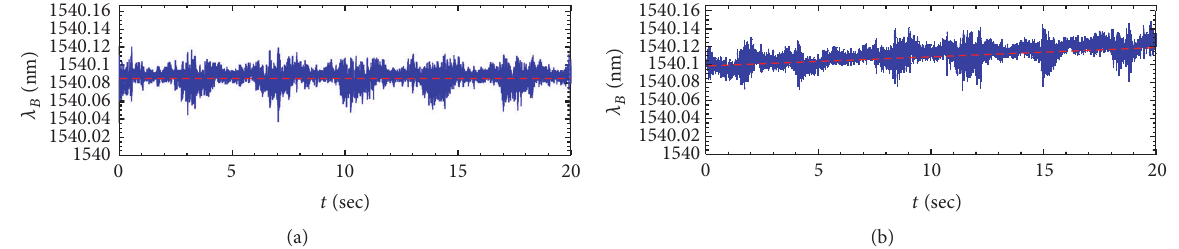
Figure 9: Time-series of Bragg wavelength fluctuations ( 𝜆 𝐵 ) for 20 seconds under PA-OFF and PA-ON conditions which are detected by FBG sensor attached to exterior surface of cantilever (Figure 8(b)). (a) Under PA-OFF, intermediate 𝜆 𝐵 value was found to be constant,